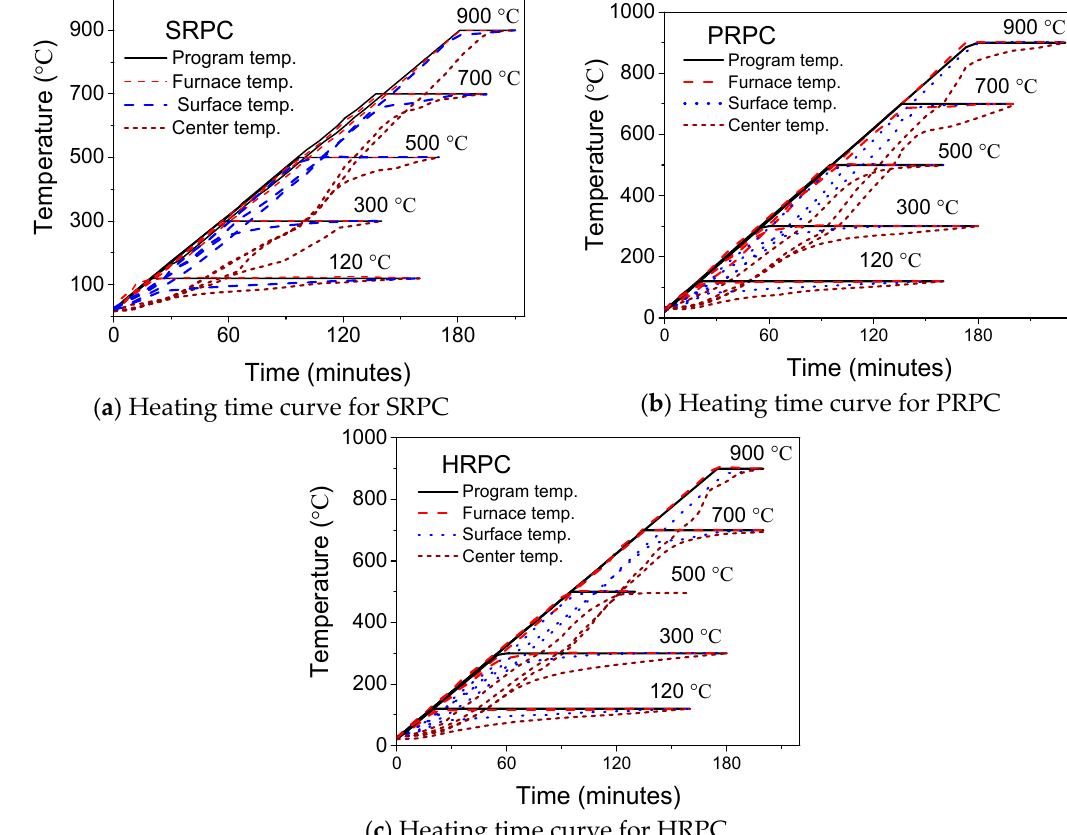
Figure 2. Heating-time curve for high-temperature mechanical testing.